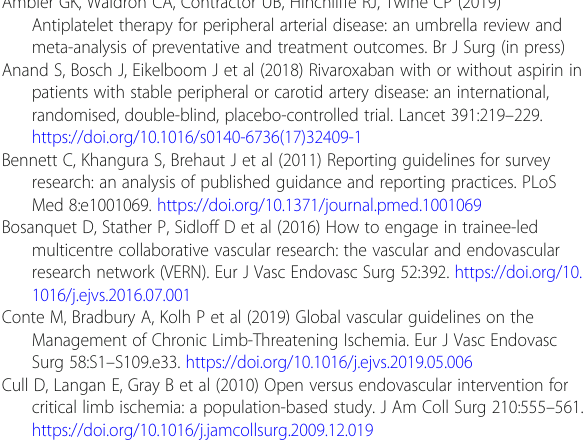
Additional file 1: Figure S1. Published protocol and final survey. Additional file 2: Table S1. Full data tables for